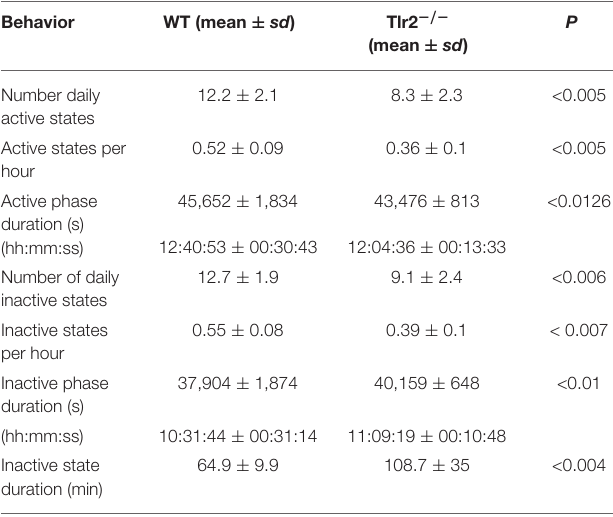
TABLE 1 | Comparison of overall active and inactive state properties between 4 and 4.5 months old WT and Tlr2 − / − mice.